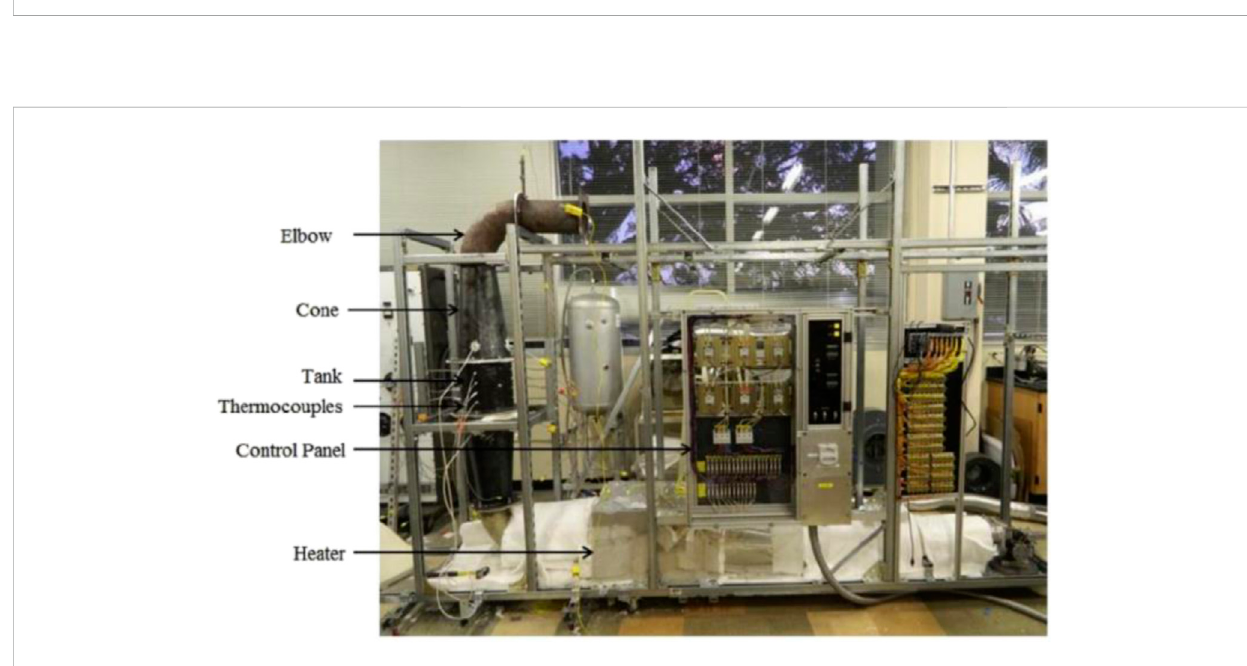
FIGURE 4 Energy storage system laboratory using PCM capsules made of molten salt (Bellan et al., 2015). License Number: